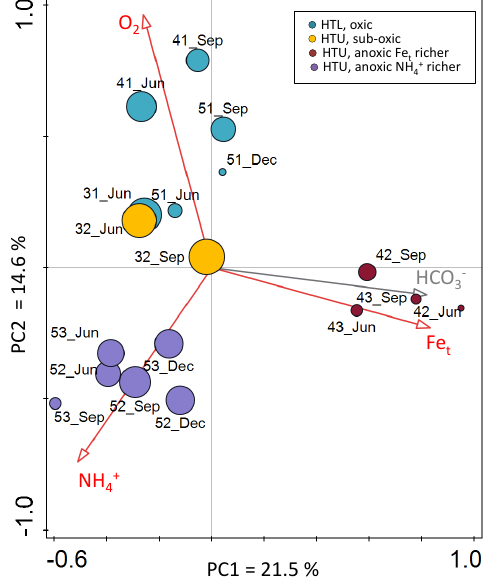
Figure 5. Redundancy analysis (RDA) of PLFAs, used as species, and the most significant environmental parameters O 2 , NH + and 4 Fe t that explained 39.9% of the variability. The different wells are represented by dots with different colours: blue for oxic groundwa- ter, yellow for sub-oxic groundwater, dark red and violet for anoxic groundwater richer in Fe t and NH + 4